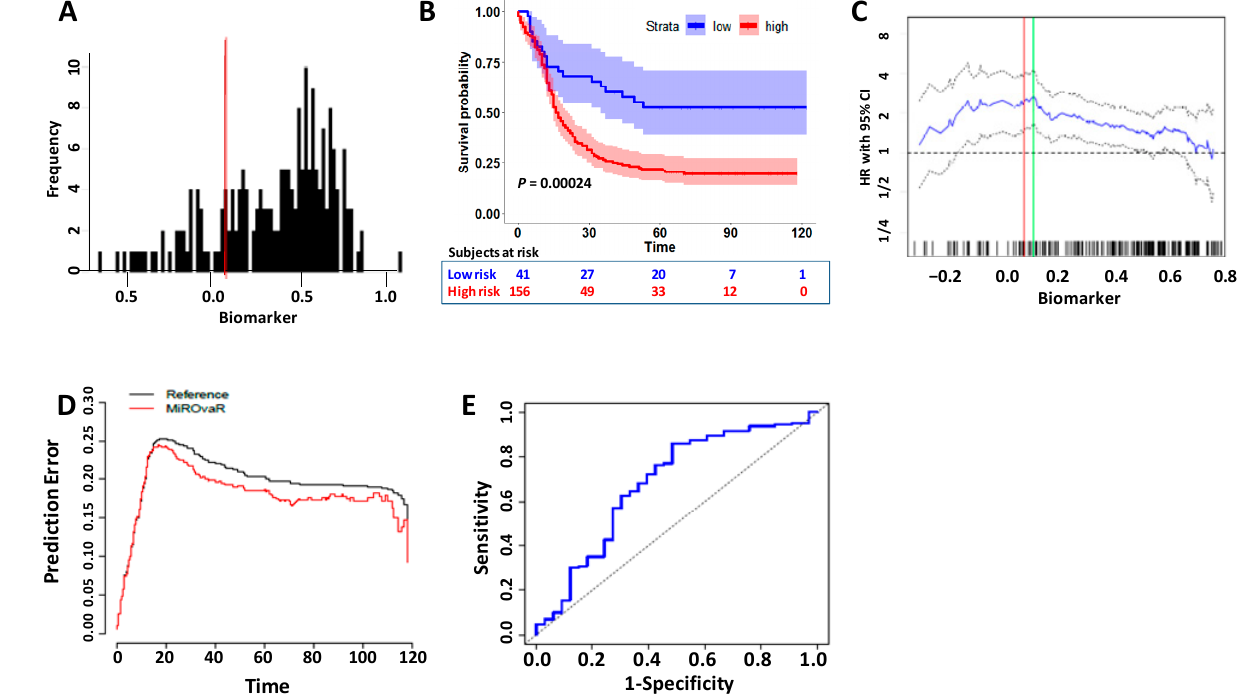
Figure 1. Progression-free survival (PFS) of epithelial ovarian cancers (EOC) patients in Prahm’s dataset (GSE94320) stratified by risk according to MiROvaR model. ( A ). MiROvaR index. Affymetrix microarray data were retrieved from Gene Expression Omnibus (GEO) repository and MiROvaR index was computed in GSE94320 after adjustment to account for the microarray platforms. The bar-plot depicts the MiROvaR index showing skewness = − 0.756 and kurtosis = 2.93. The red bar shows the model cutoff value (=0.07359) as determined in our original paper and used in the present analysis. ( B ). Kaplan–Meier curves according to the MiROvaR value as cutoff: blue and red lines indicate low- and high-risk patients reaching HR = 1.42 (CI 1.49–3.93), p = 0.00024. High- and low-risk curves were compared with the long-rank test. HR = hazard ratio. Shadows indicate upper and lower 95% confidence intervals. ( C ). Hazard ratio assessed with PFS as the endpoint and independent of the cutoff point for the MiROvaR index. The red bar shows the model cutoff value (=0.07359), while the green bar designates the optimal cutoff point (=0.1085) with the most significant HR split. Solid and broken lines indicate the HR and the 95% confidence intervals. ( D ) Curves of time-dependent prediction errors by Brier scores to evaluate MiROvaR performance for predicting PFS in EOC. The Brier score for our model (red line) is computed along with the reference (i.e., the marginal Kaplan–Meier estimator, ignoring the predictors). ( E ). Time-dependent receiver operating curve (ROC) in Prahm’s dataset for MirOvaR predicting 72-month time point. The AUC is = 0.68 (95% CI 0.57–0.79).